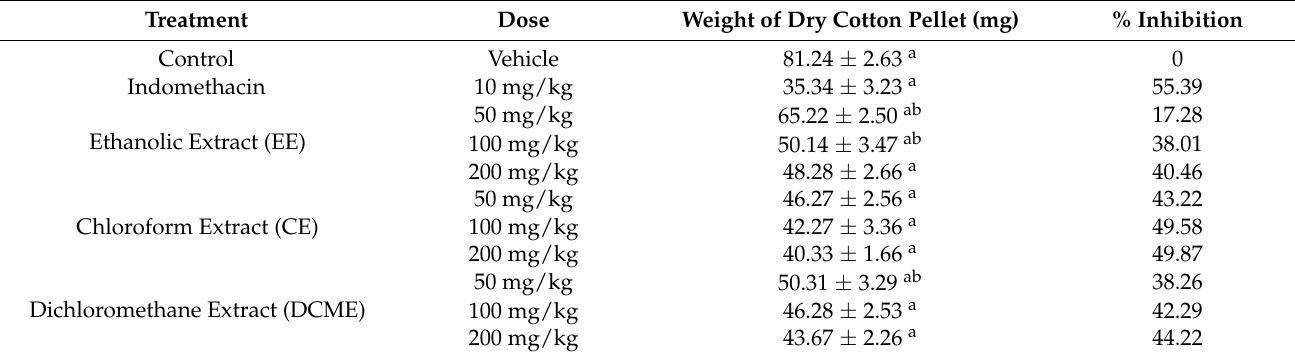
Table 9. Effect of ethanolic extract (EE), chloroform extract (CE) and dichloromethane extract (DCME) of N. triquetra on cotton pellet granuloma in rats.